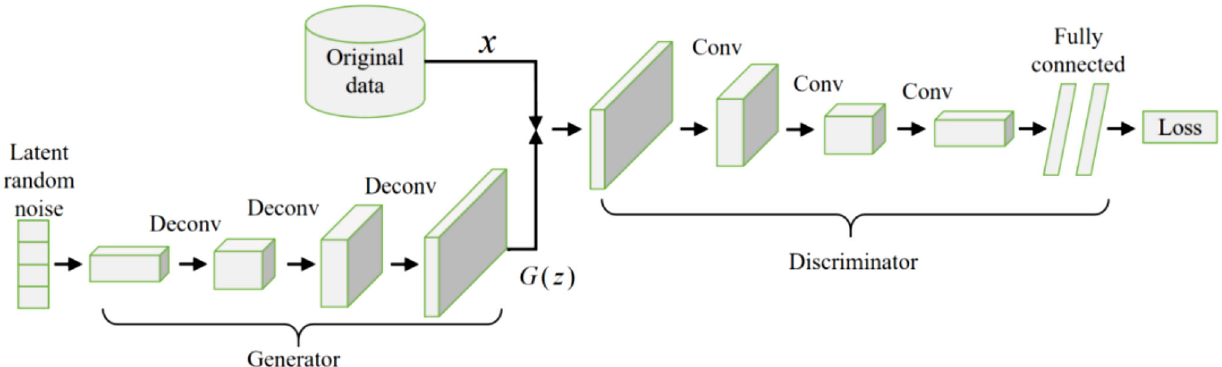
Fig. 1 The architecture of vanilla GAN is used to reconstruct imputed data by another GCN